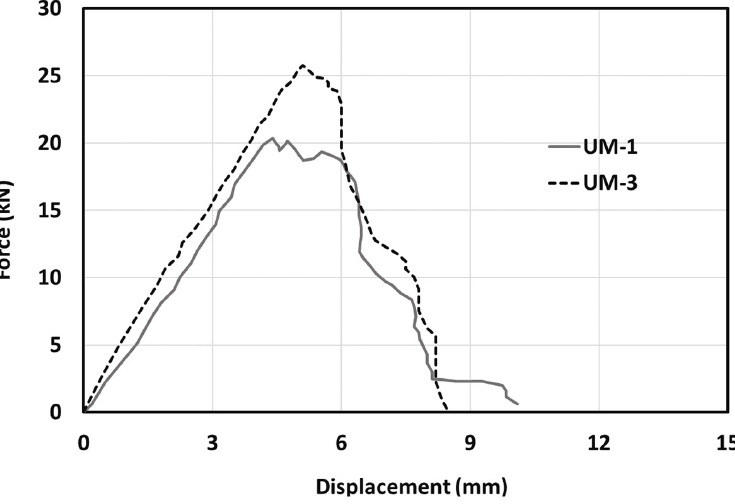
Figure 15. Force–displacement curves of two UM panels under diagonal compressive test. Table 4. Results of diagonal compressive tests on unreinforced masonry (UM) panels.